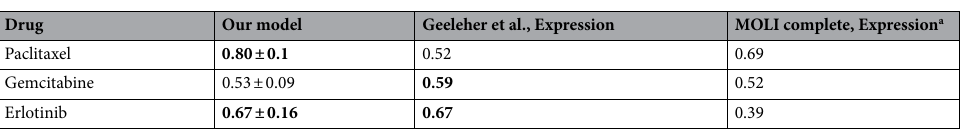
Table 2. Methods comparison based on area under the receiver curve (AUROC) of three drugs in the PDX-D dataset. The best performance is in bold. a The performance scores were adopted from Sharifi-Noghabi (2015)’s